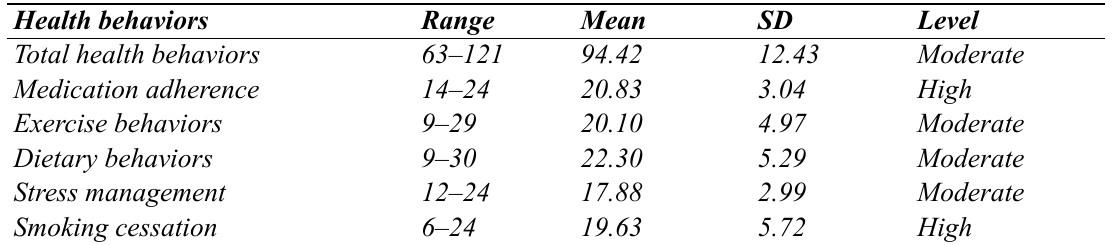
Table 2. Range, mean and standard deviation of health behaviors (N = 60) Health behaviors